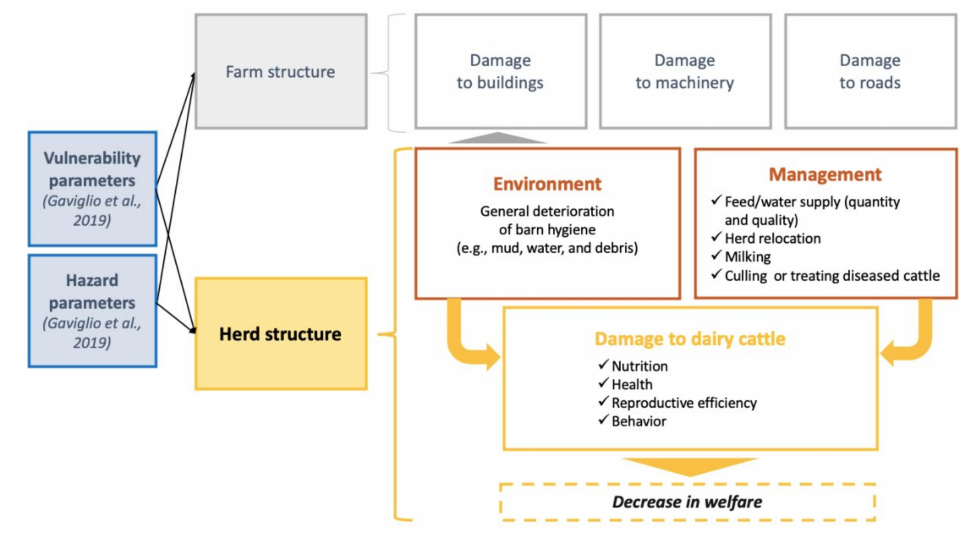
Figure 1. Frameworkforfloodingdamagetodairycattlefarms(expandeduponthatinGaviglio et al., 2019).